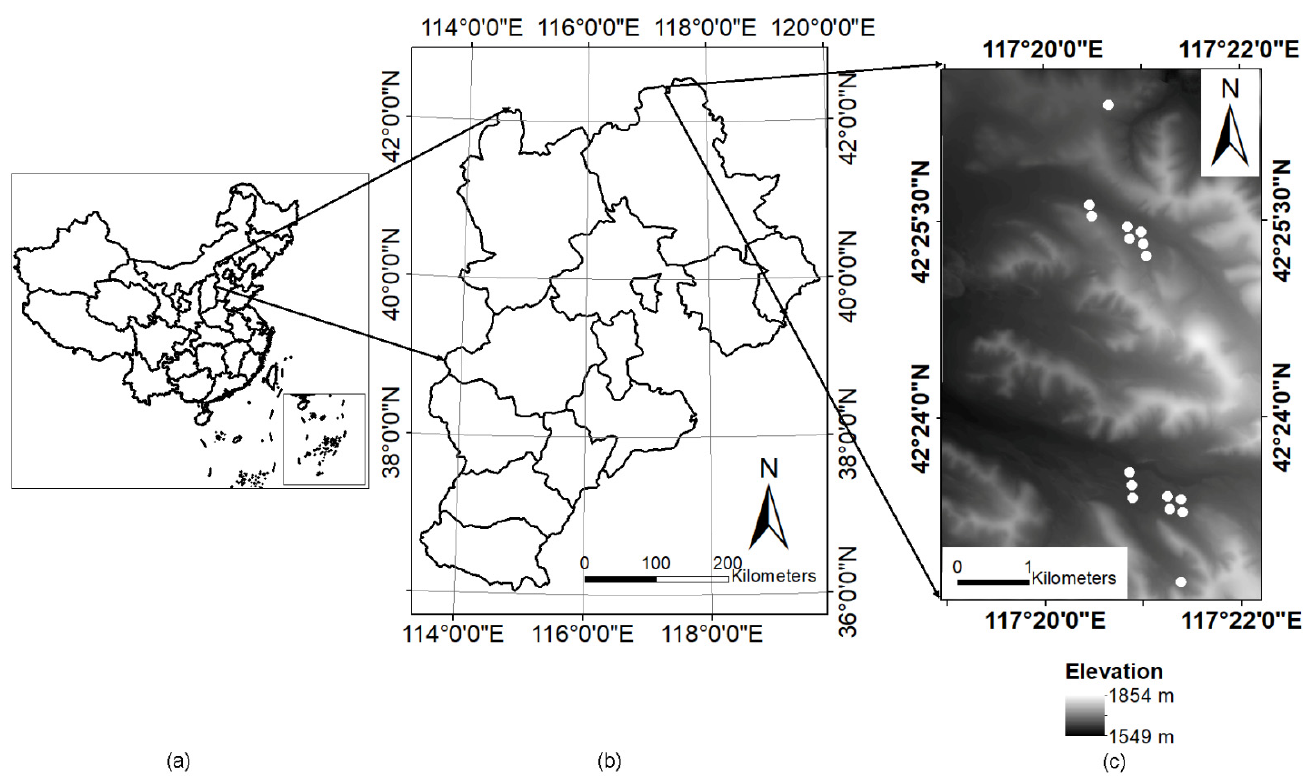
Figure 2. Location of the study area, with the sampling plots marked with white dots. ( a ) China; ( b ) Hebei Province; ( c ) study area.